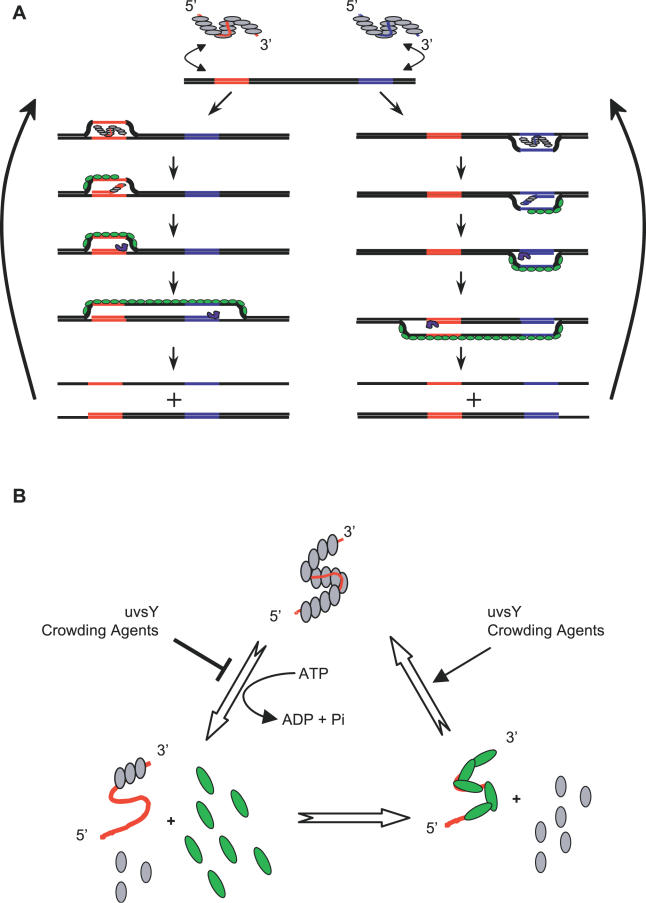
Schematic of the RPA Process and the Recombinase/Primer Filament Formation(A) Recombinase/primer filaments scan template DNA for homologous sequences (red/blue). Following strand exchange, the displaced strand is bound by gp32 (green), primers are extended by Bsu polymerase (blue). The net result of two opposing primer binding/extension events is the generation of one complete copy of the amplicon in addition to the original template. Repetition of the process results in exponential DNA amplification.(B) In the presence of ATP, uvsX (gray) binds cooperatively to oligonucleotides (red, top). Upon ATP hydrolysis, the nucleoprotein complex disassembles (left) and uvsX can be replaced by gp32 (green, right). The presence of uvsY and Carbowax20M shifts the equilibrium in favour of recombinase loading.